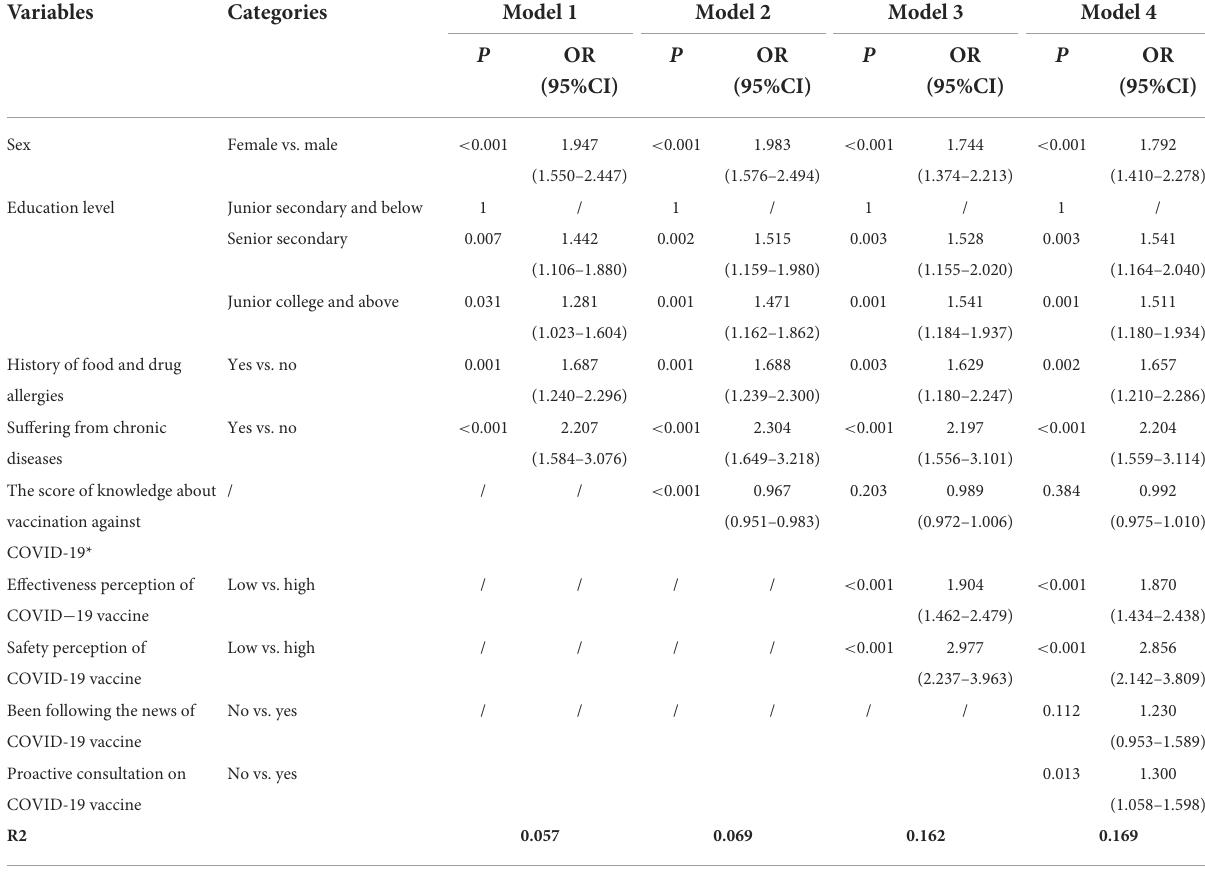
TABLE 3 Binary logistic regression analysis of factors associated with populations’ COVID-19 vaccine hesitancy ( n =